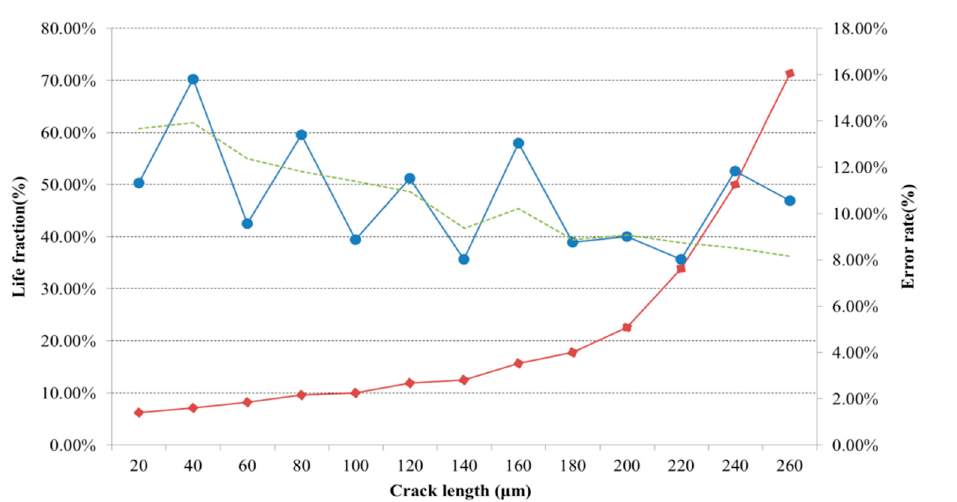
Figure 7. Lifetime estimation and error rate of different porosity and legend in variation of crack length of using the information entropy model.